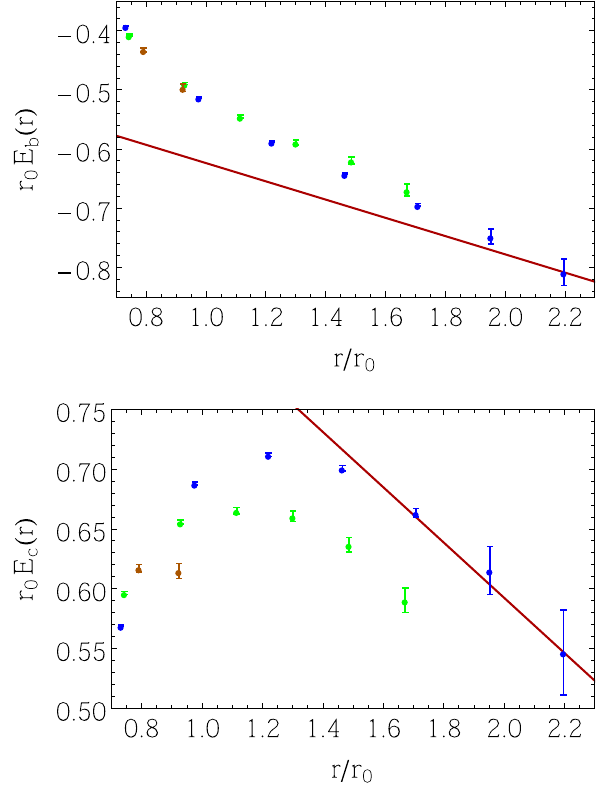
Fig. 11 Comparison of the lattice data with the predictions from effec- tive string theory at long distances for E b and E c